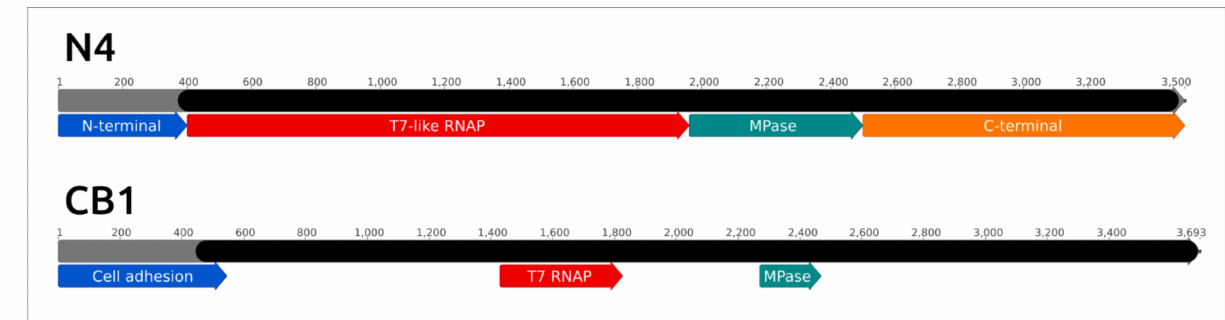
Figure 11. The scheme illustrating the positions of protein domains in the primary sequences of vRNAP of Escherichia phage N4 (upper scheme) and Pectobacterium phage vB_PatP_CB1 (lower scheme). The scale shows the position of amino acid residues starting from the N-end of the protein. The parts of N4 and CB1 vRNAPs coloured black are similar, according to the HHpred analysis. The parts of N4 vRNAP coloured blue, red, green and orange indicate the positions of N-terminal, T7-like RNAP, zincin-like metalloprotease and C-terminal domains, respectively, according to [154]. The parts of vB_PatP_CB1 vRNAP coloured blue, red and green indicate the positions of structurally similar parts of proteins, including the cell adhesion catenin alpha-1 (PDB structure 4K1N, Phyre2 confidence 99.5%), T7 RNAP (PDB structure 1MSW, Phyre2 confidence 93.5%) and metalloprotease PPEP-2 (PDB structure 6FPC, Phyre2 confidence